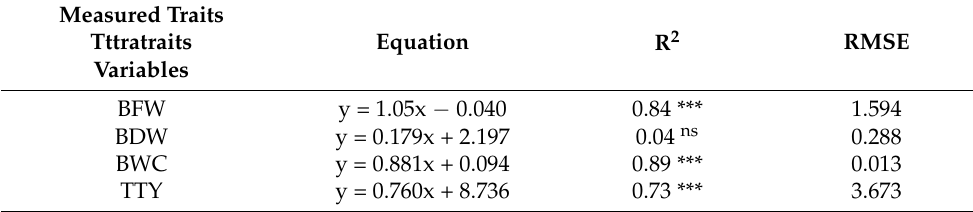
Table 4. Function of Linear Validations between the Observed and Predicted Values, Coefficient of Determination (R 2 ), and Root Mean Square Error (RMSE) of Linear Regression Models Based on Thermal and RGB Imaging Indices. The Best Fitted Equations of Calibration of Distinct Models (Table 3) Were Used to Predict Biomass Fresh Weight (BFW) Biomass Dry Weight (BDW), Biomass Water Content (BWC), and Total Tuber Yield (TTY) Based on 25% of Dataset (n =